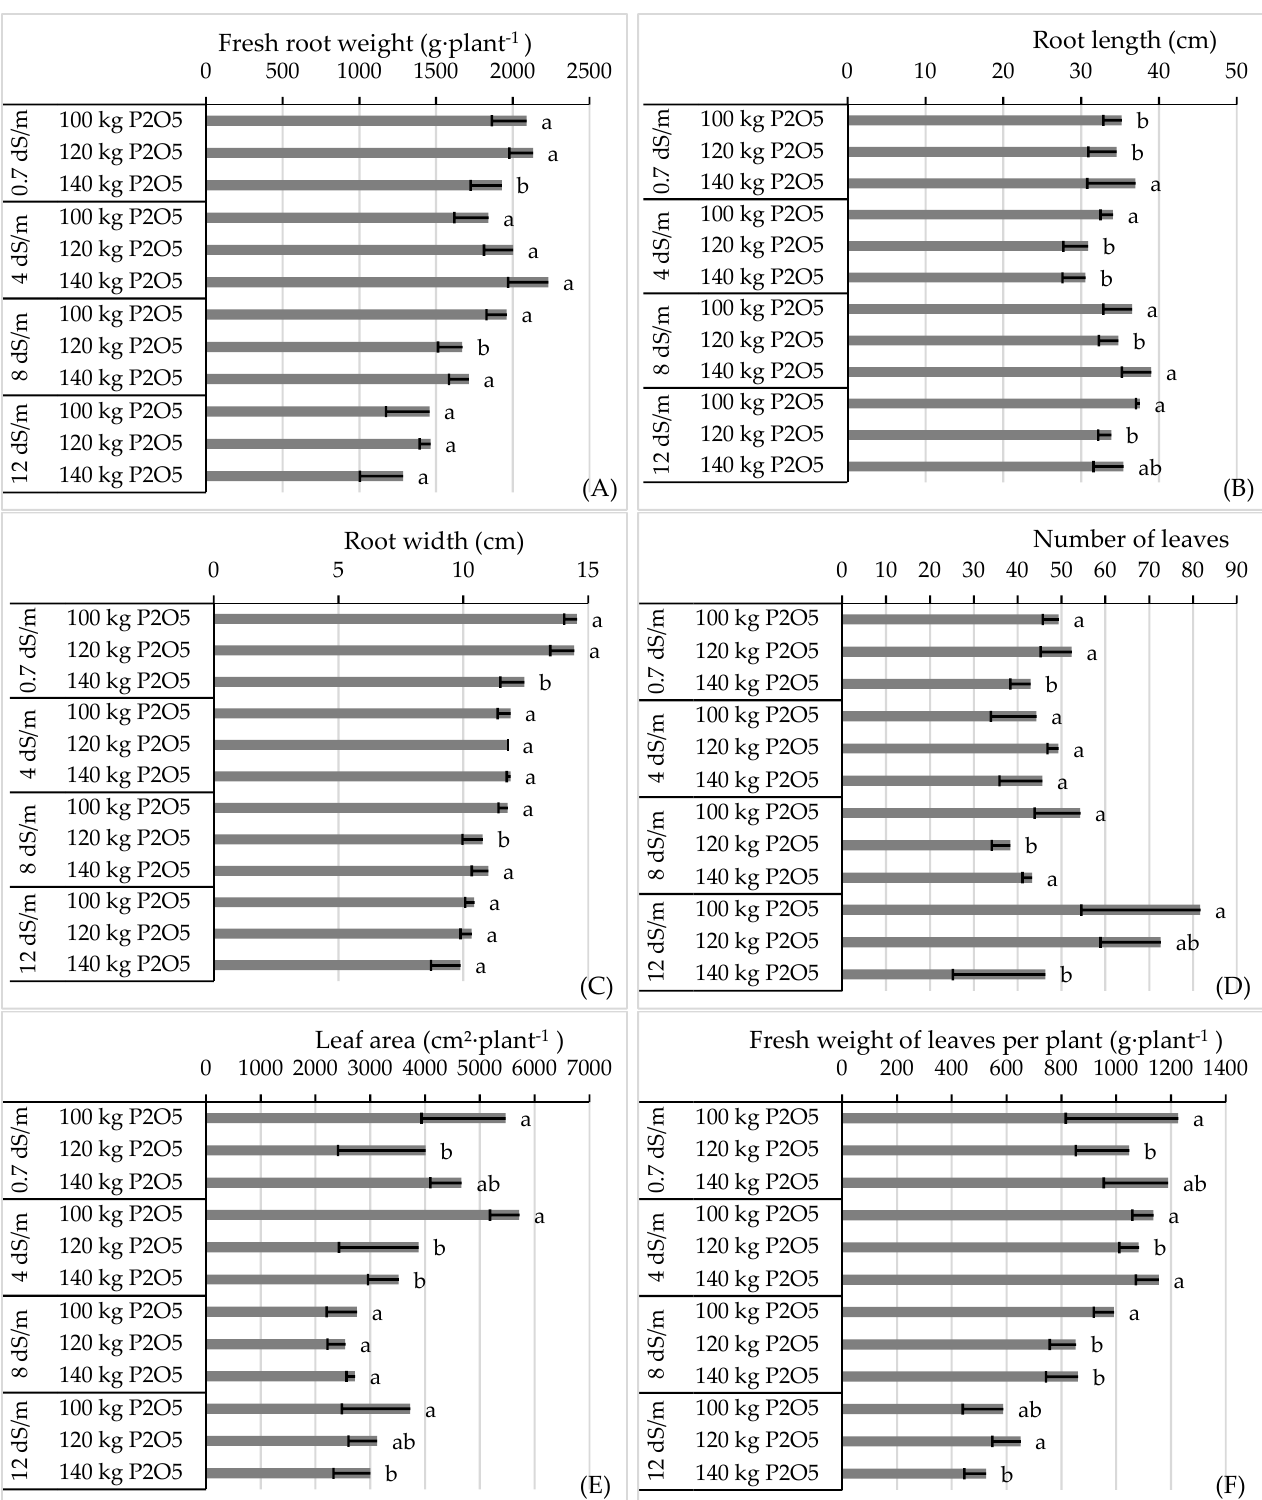
Figure 2. Final growth parameters, including fresh root weight per plant ( A ), root length ( B ), root width ( C ), number of leaves per plant ( D ), leaf area ( E ), and fresh weight of leaves per plant ( F ). Error bars indicate the standard deviation. Phosphorus treatments under the same salinity level without a common letter are significantly different at p < 0.05.